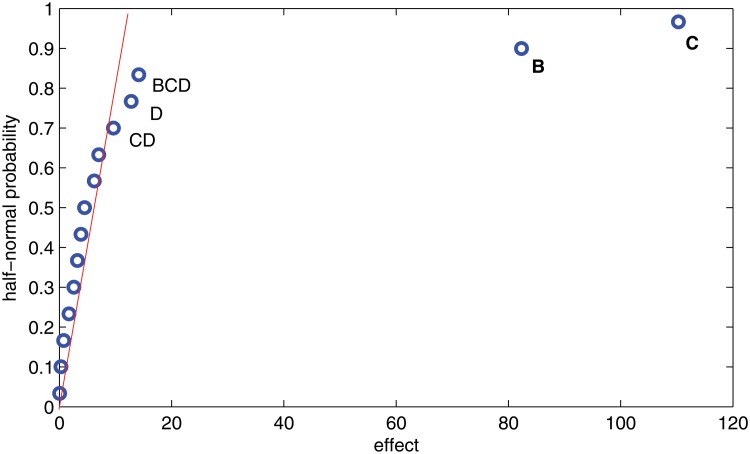
Half-normal plot of effects for Y
e.